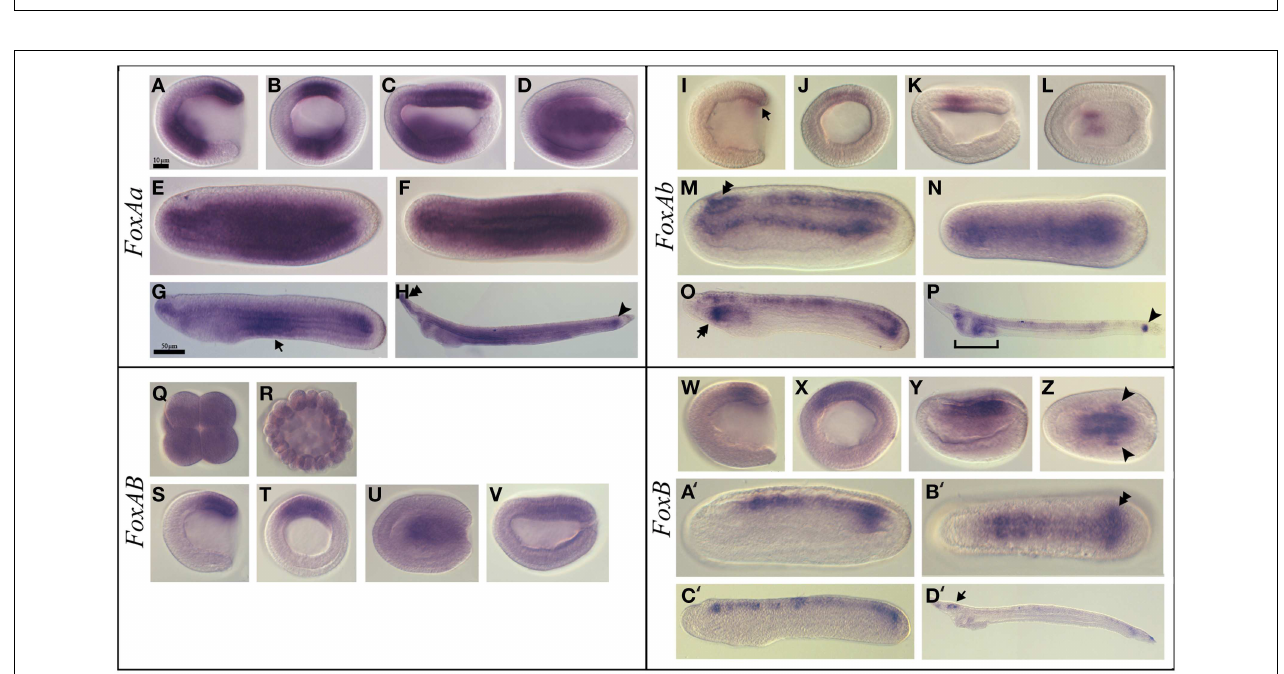
FIGURE 2 | Expression of B. lanceolatum FoxAa , FoxAb, FoxAB, and FoxB . In all the panels except (B, J, Q, R, T, X) anterior is to the left. In lateral and blastoporal views dorsal is to the top. FoxAa expression pattern (A–H) . Gastrula lateral (A) and blasporal (B) views. Late gastrula lateral (C) and dorsal (D) views. Mid-late neurula lateral (E) and dorsal (F) views. In the late neurula lateral view (G) arrow marks the endodermal expression in the middle region. In the larva stage lateral view (H) , the double arrowhead indicates the expression in the anterior tip of the notochord and the arrowhead marks the expression in the tailbud. FoxAb expression pattern (I–P ). In the gastrula lateral (I) and blastoporal (J) views the arrow indicates the expression in the mesendodermal part of the dorsal blastoporal lip. Late gastrula lateral (K) and dorsal (L) views. In the mid-late neurula lateral (M) and dorsal (N) views the double arrowhead marks the expression in the